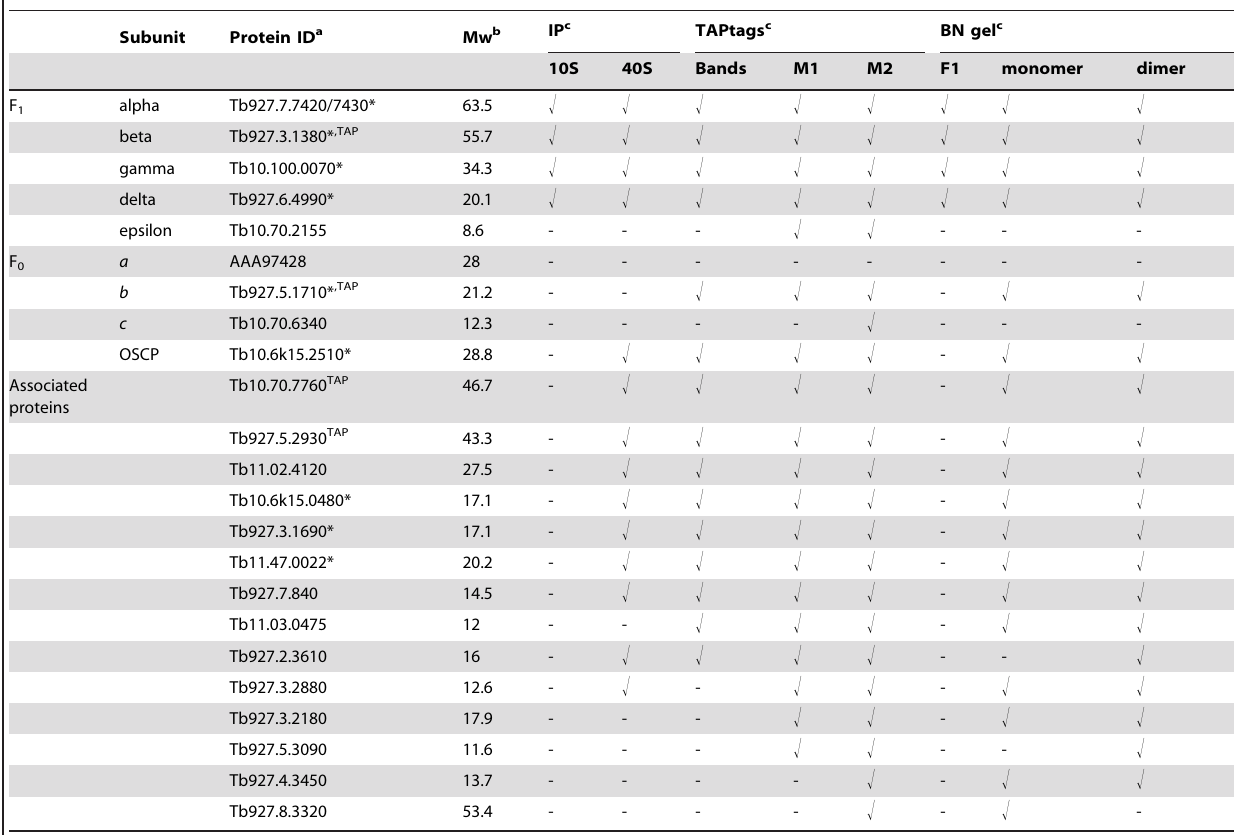
Table 2. Trypanosoma brucei F 0 F 1 -ATP synthase subunits.